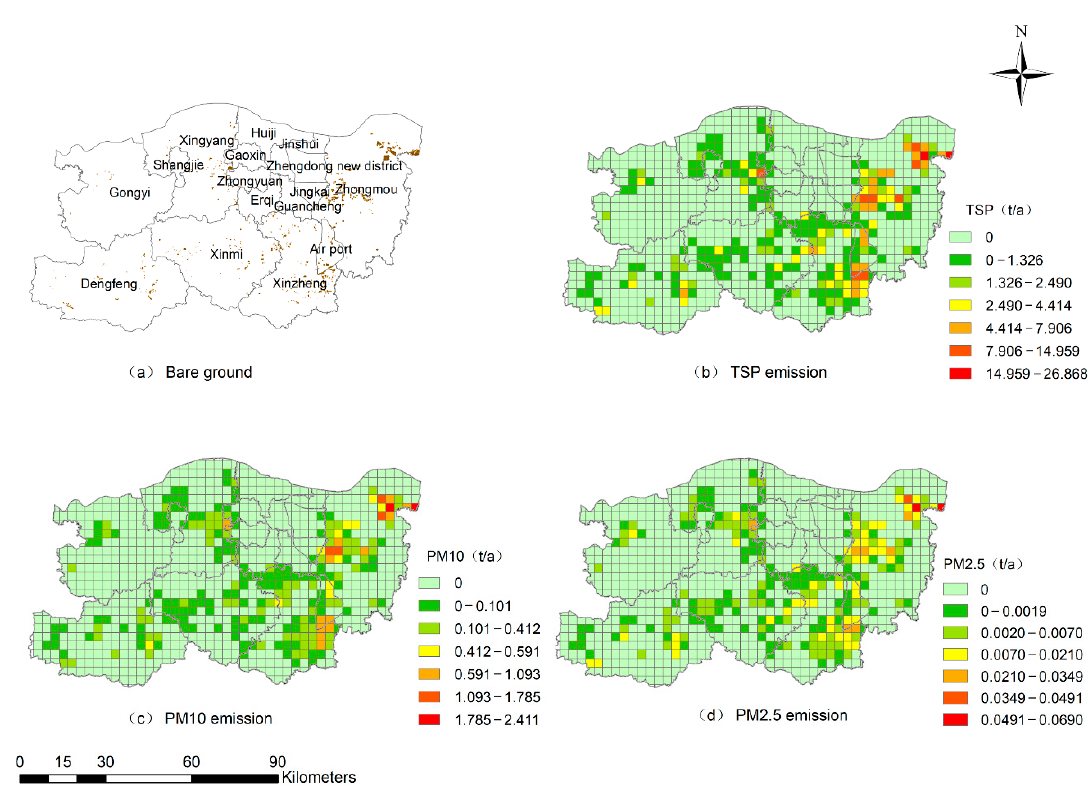
Figure 3. Spatial distribution of PM emission from soil dust source.